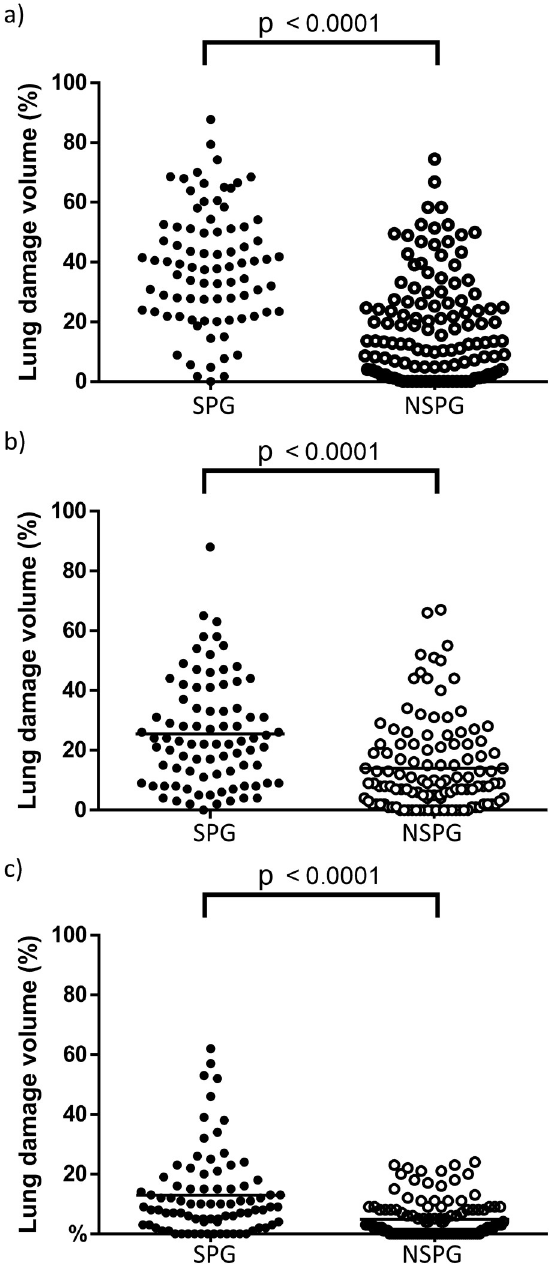
Fig 2. Comparison of the extent of lung damage on chest CT scans. a) Overall combination of GGO and consolidation. b) GGO. c)